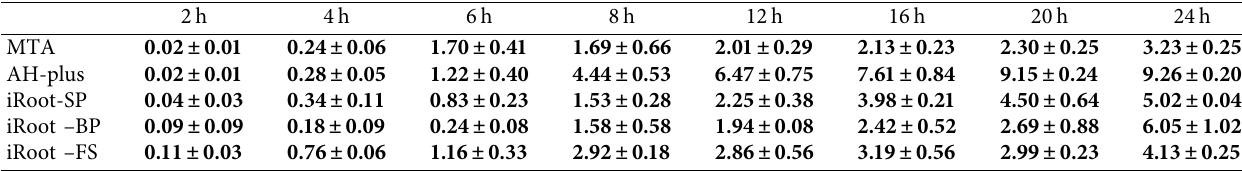
Table 7: Porphyromonas gingivalis group (plate colony